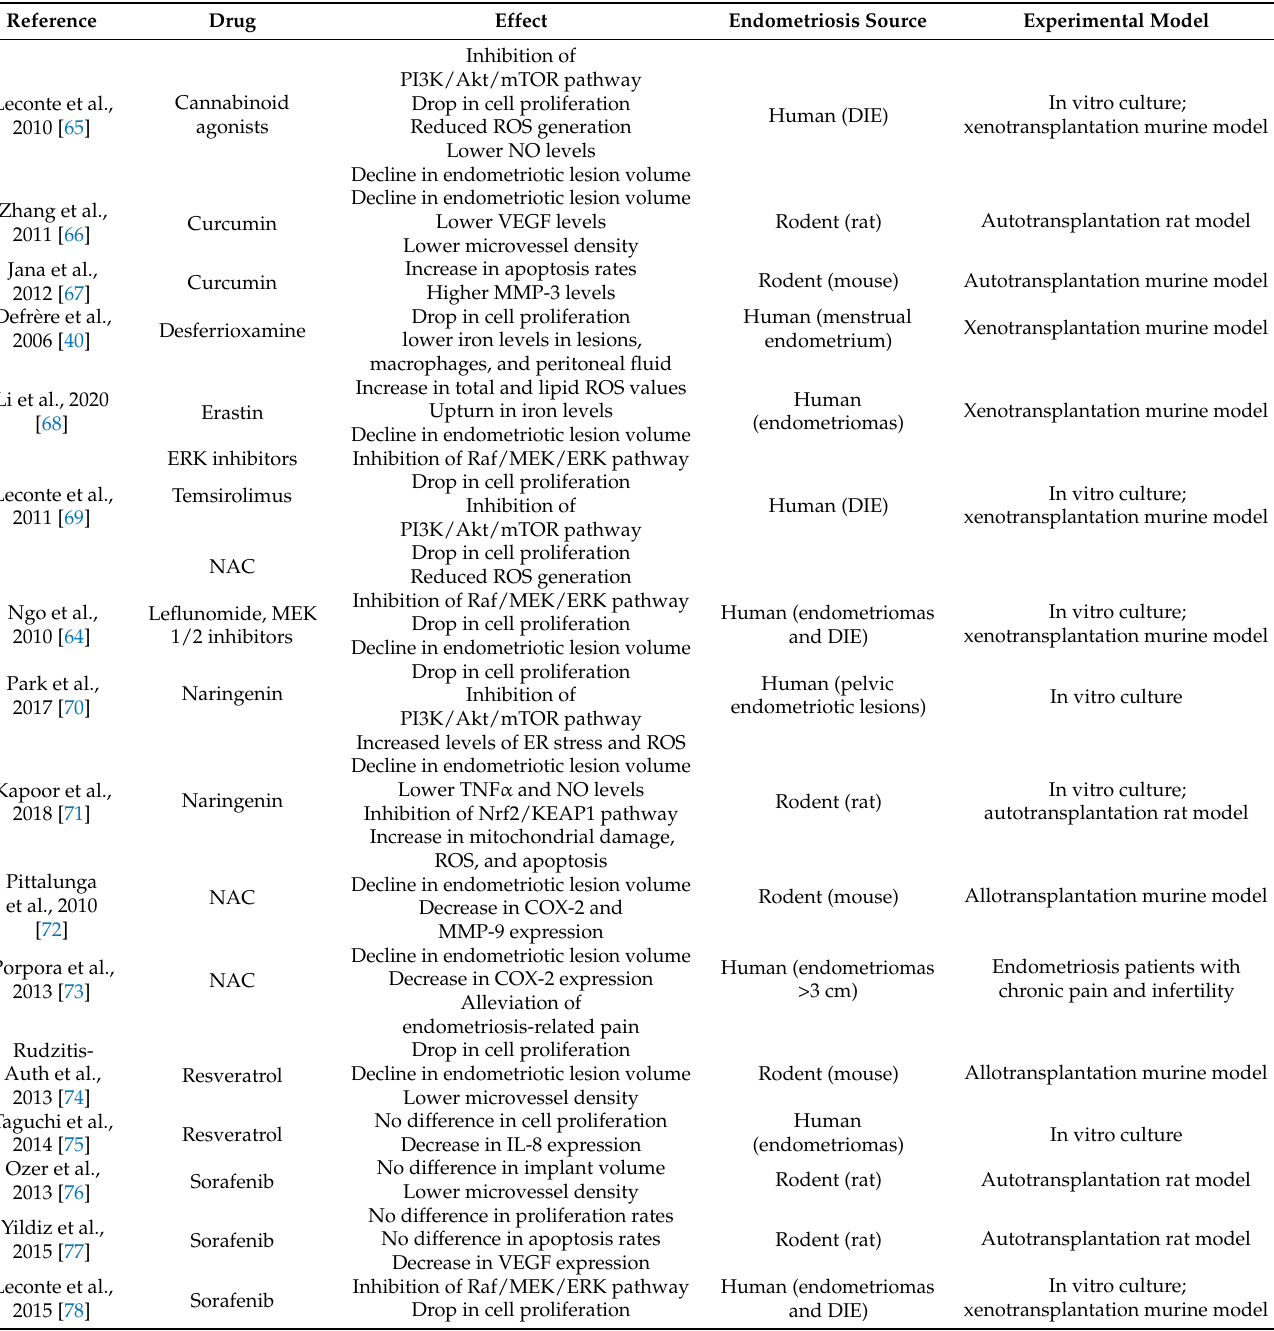
Table 1. Drugs antagonizing the hyperproliferative